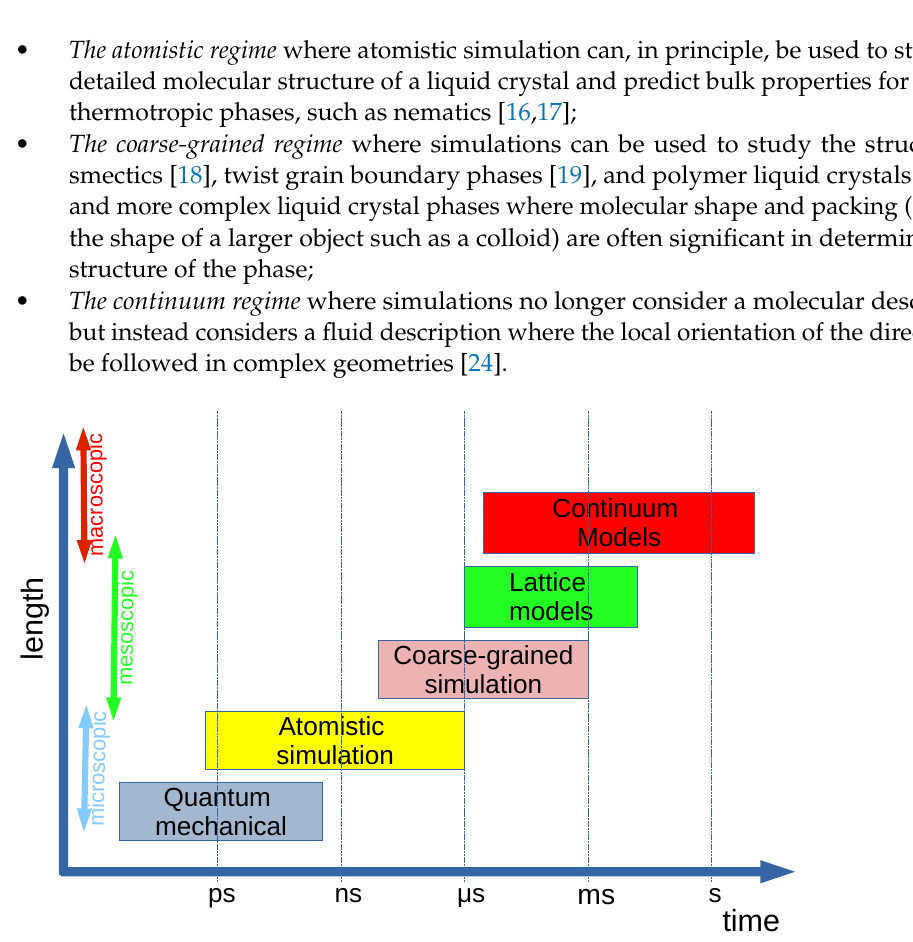
Figure 1. The time and length scale hierarchy for liquid crystal simulations covering microscopic, mesoscopic, and macroscopic